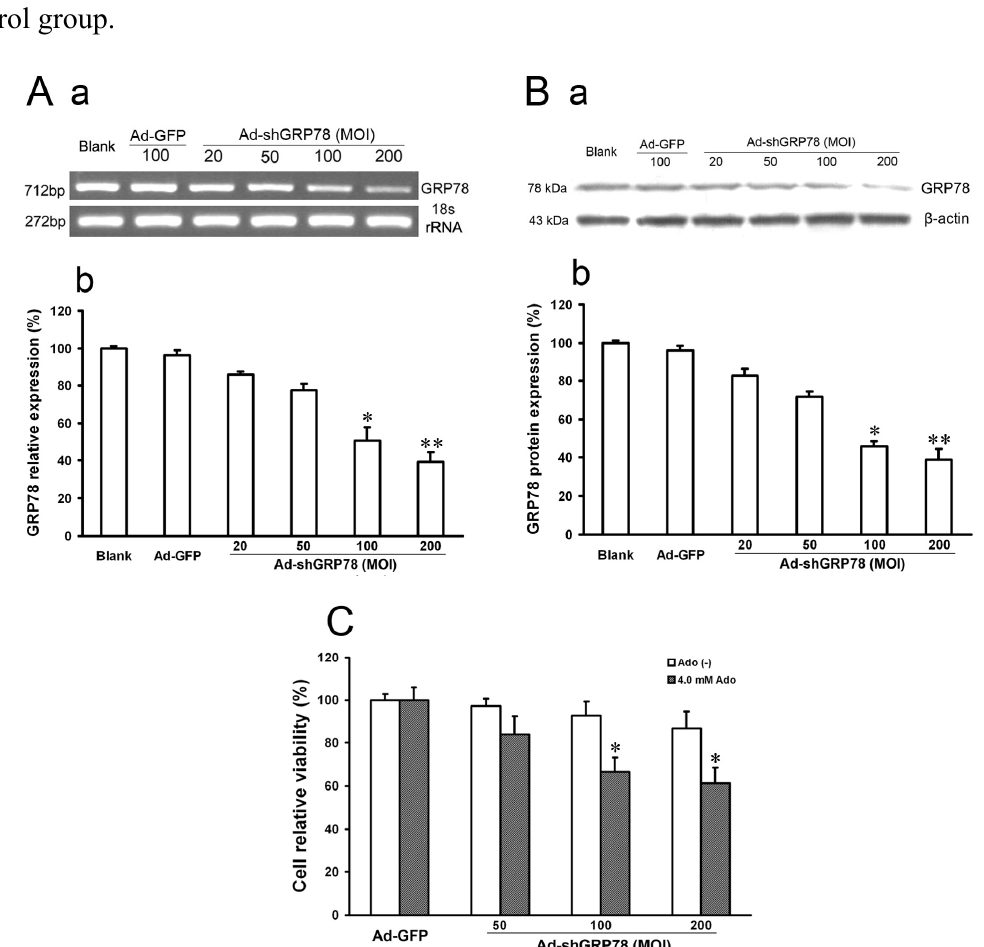
Figure 1. The effects of recombinant adenovirus vector (Ad-shGRP78) on the mRNA and protein expressions of GRP78 and cell growth. Adenoviral vector Ad-shGRP78